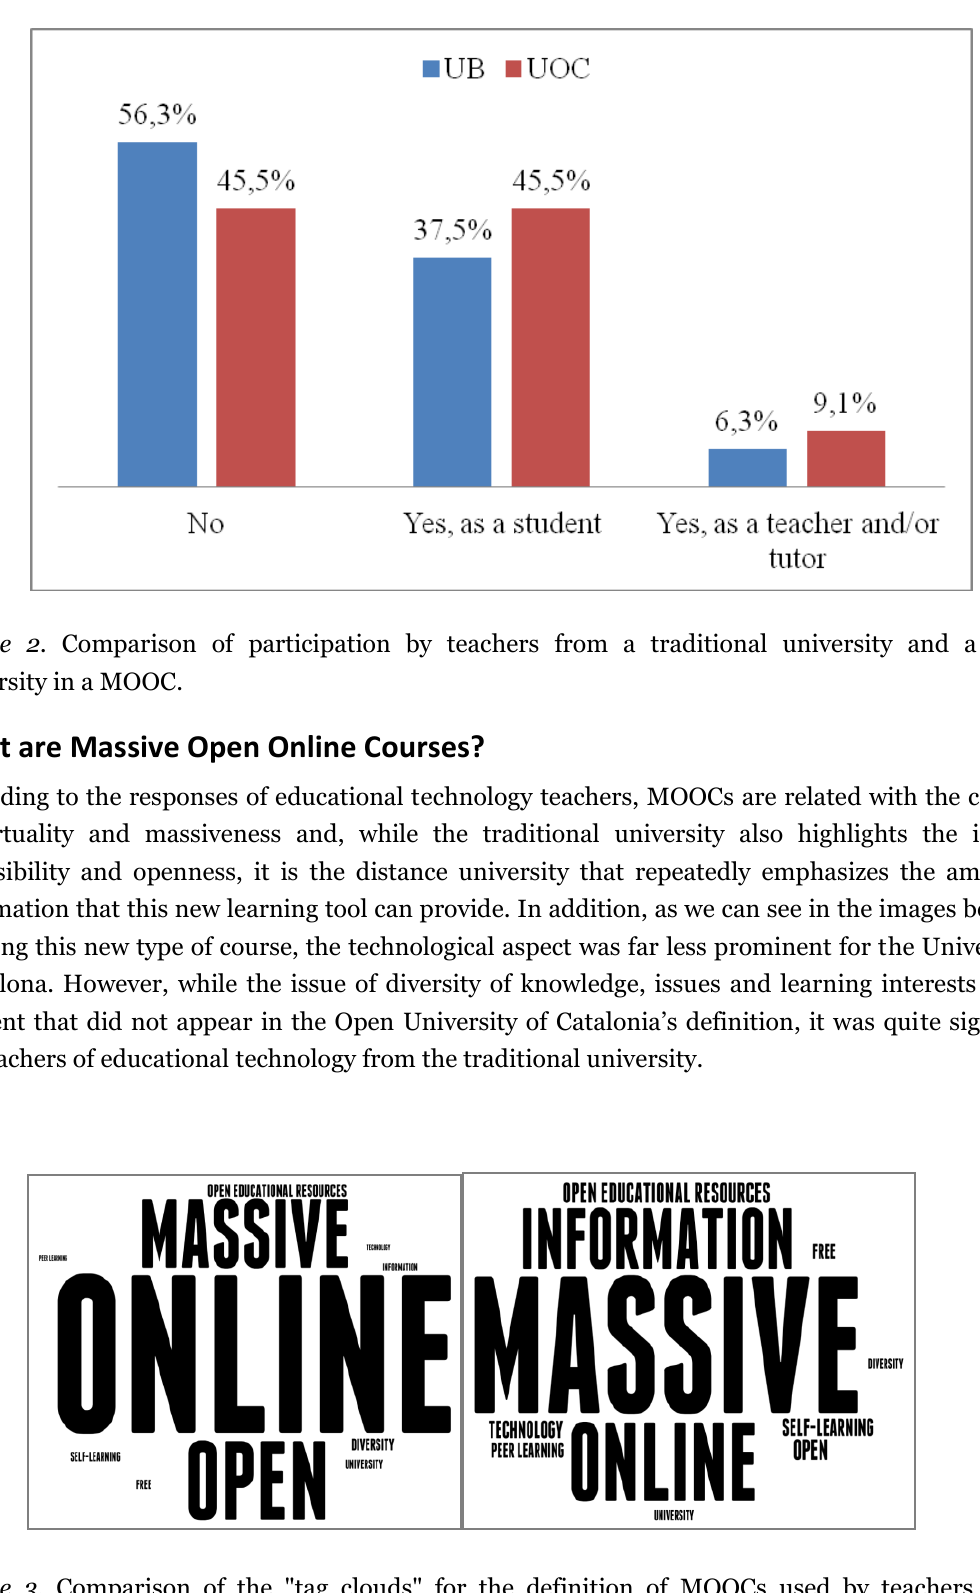
Figure 3. Comparison of the "tag clouds" for the definition of MOOCs used by teachers from a traditional university and a virtual